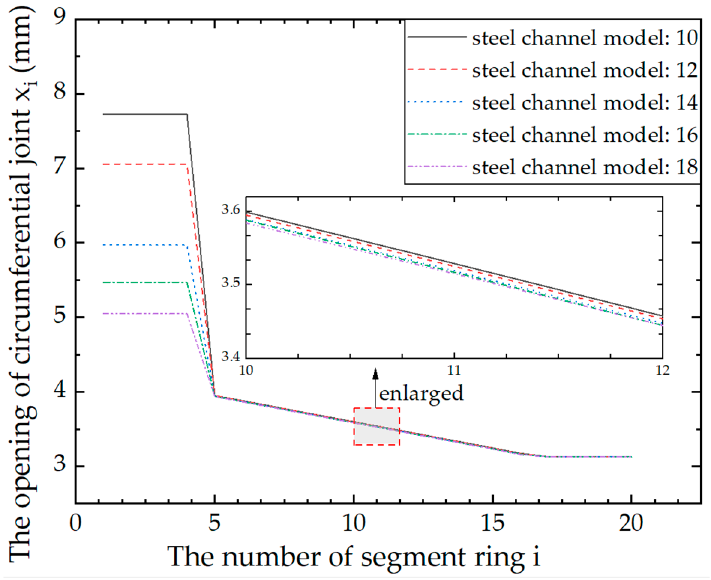
Figure 19. The relationship curve between the opening of circumferential joints and the number of rings under different models.